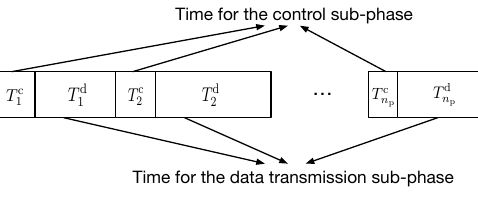
Figure 1. Several transmission phases for the high volume